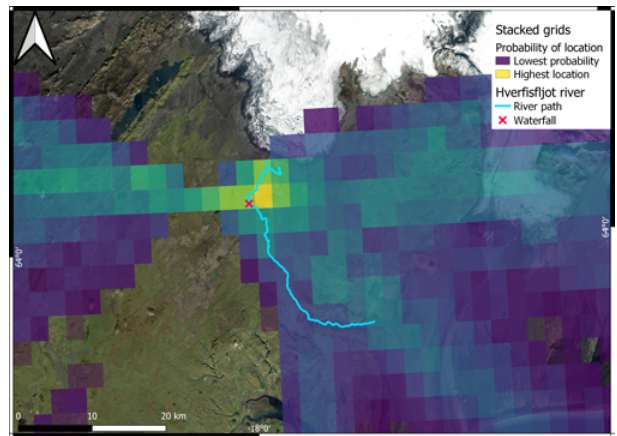
Figure 9: Map showing the stacked probabilities of lo- cation at 2.79 km s −1 for the seasonal source as well as the path of the Hverfisfljot river and the associated wa-